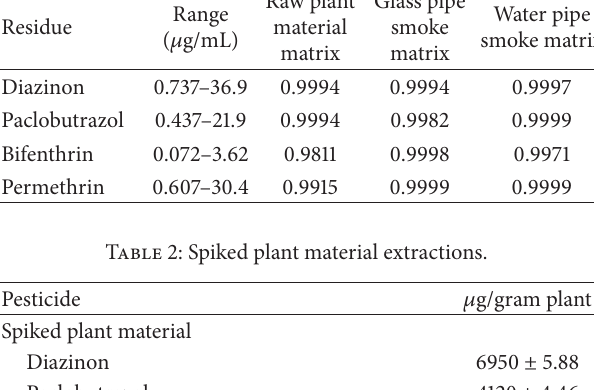
Table 1: Calibration curves and goodness of fit values. Residue